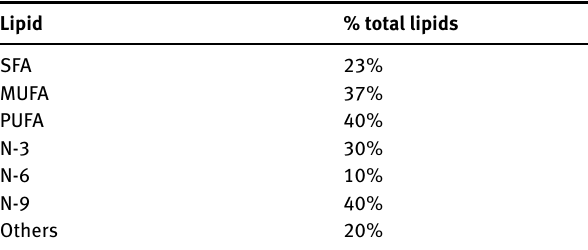
Table 1: Lipid fractionation of Chlorella vulgaris (Tokuşoglu and Ünal 2003)